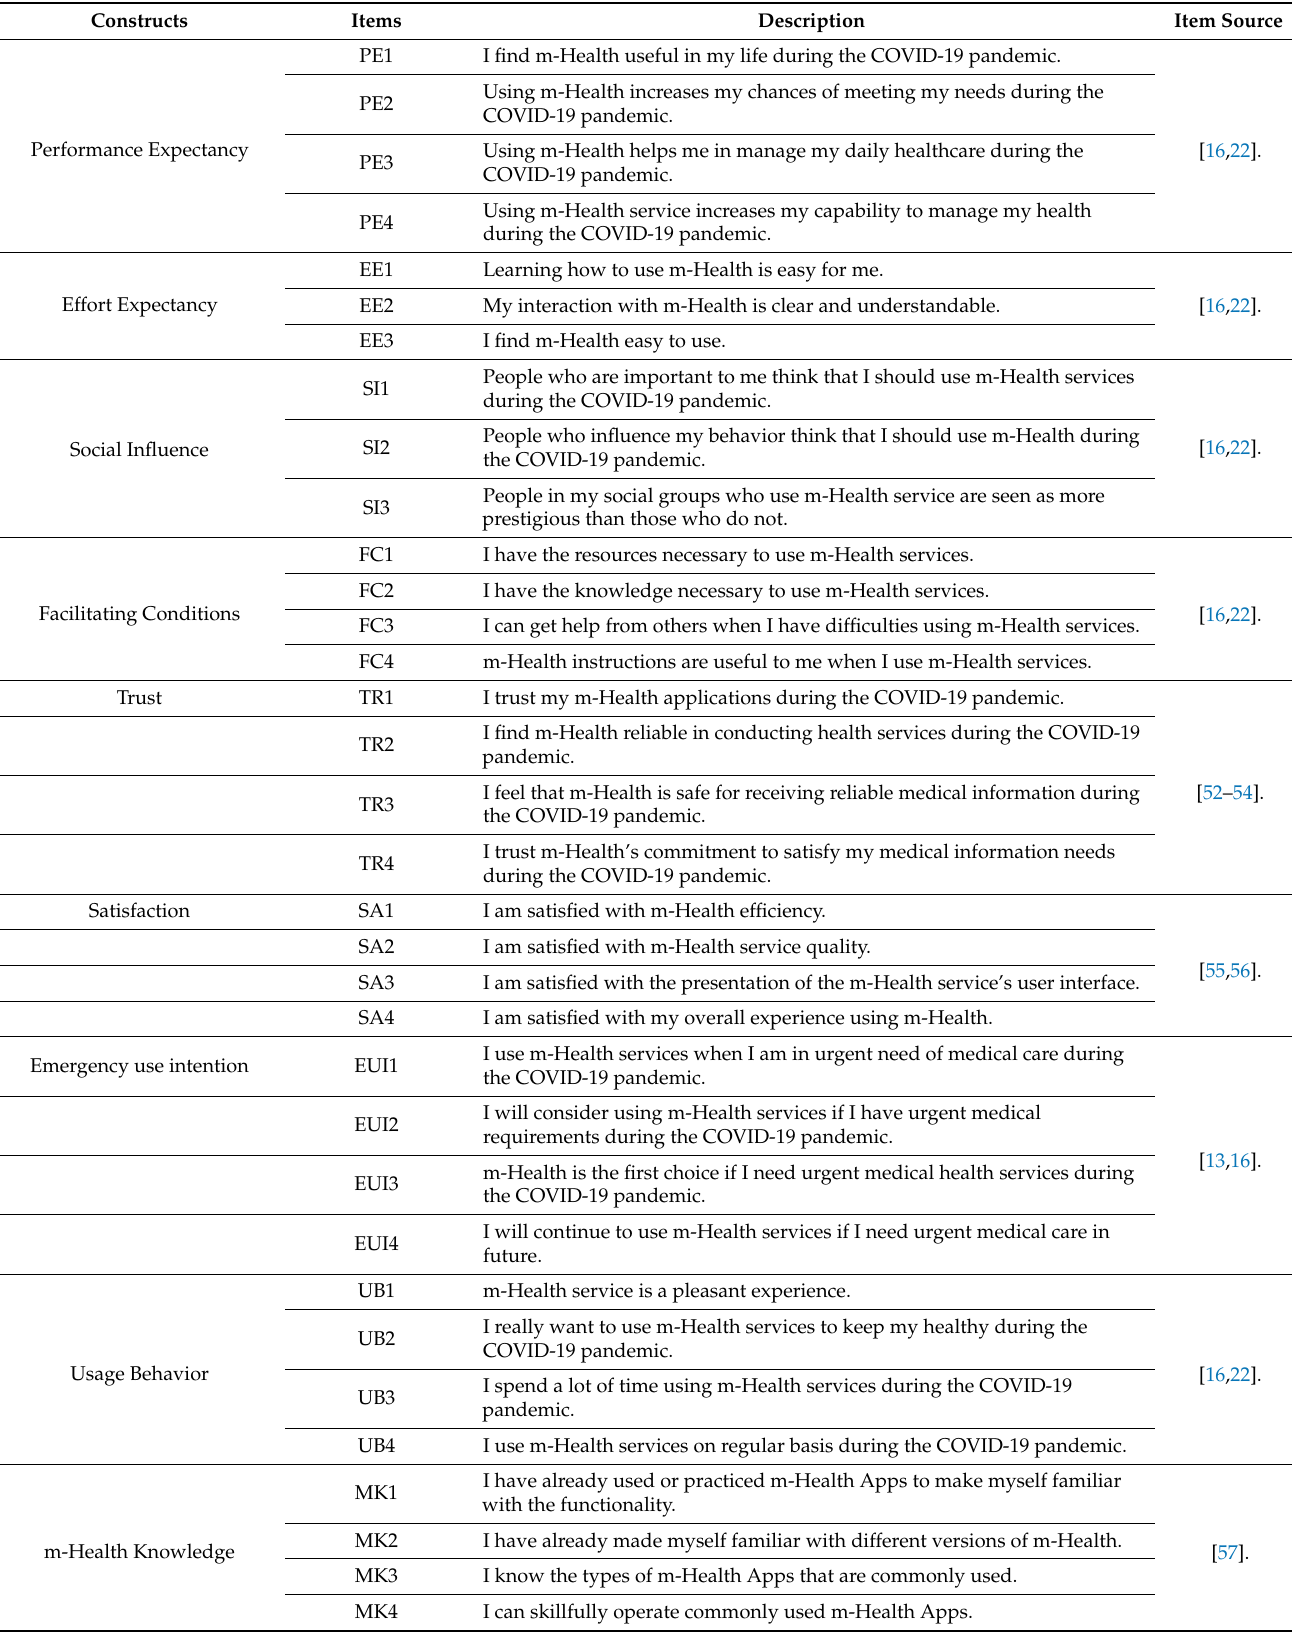
Table 1. Constructs and measurement